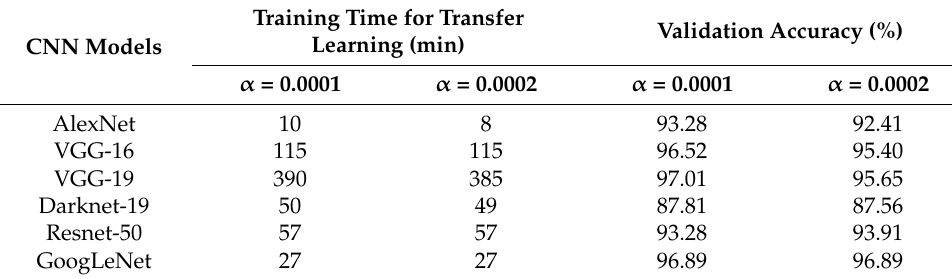
Table 3. Training results for object classification.